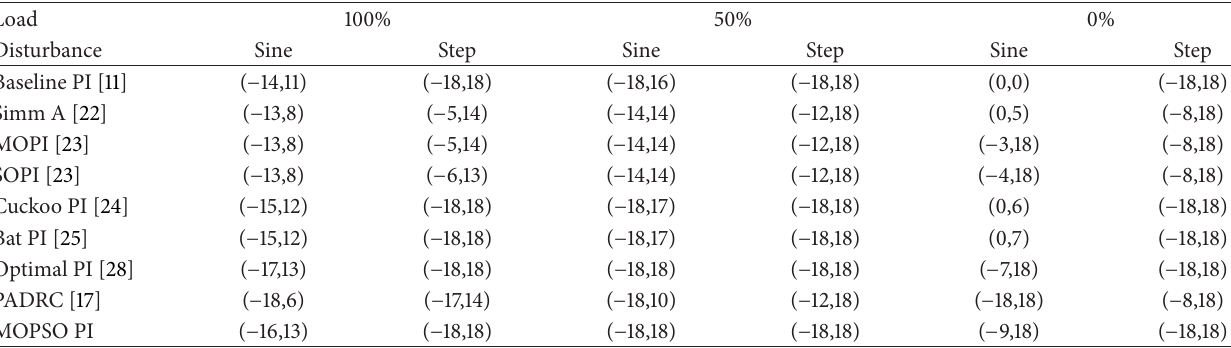
Table 8: Comparison of allowed coal quality variation